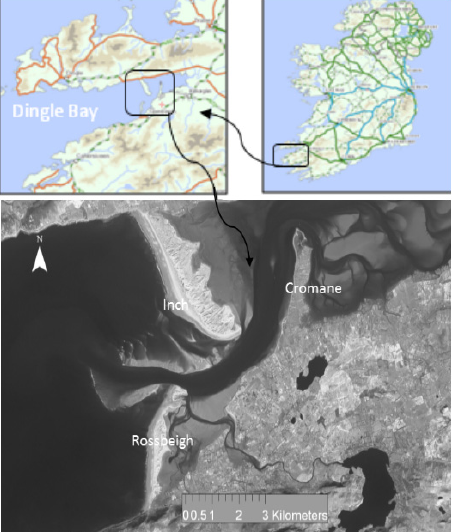
Figure 1. Study Area.